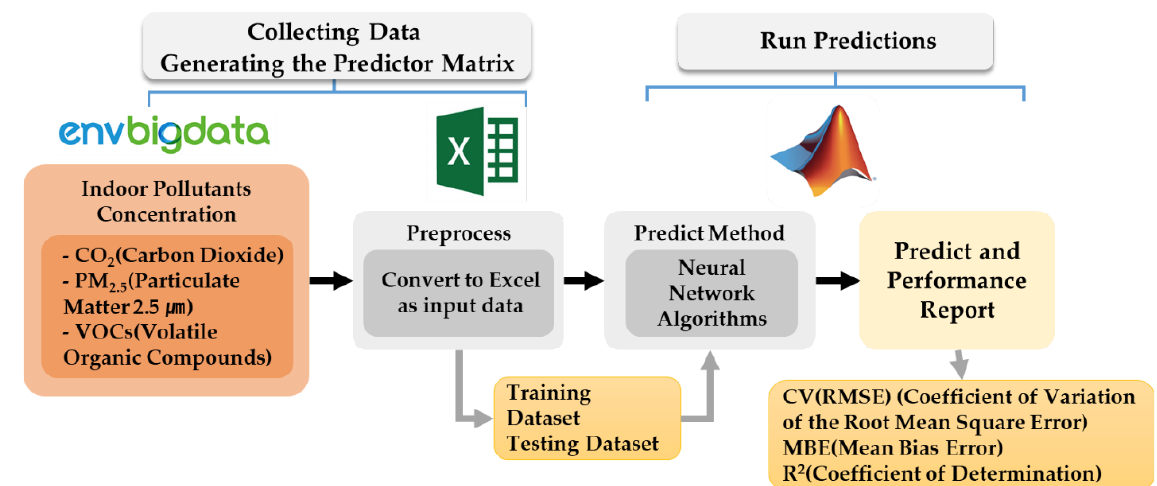
Figure 1. Schematic diagram of the process of predicting indoor air pollution concentrations.